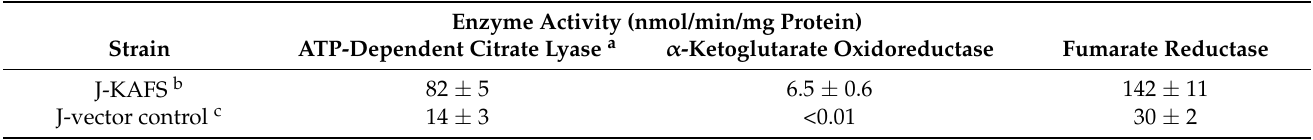
Table 1. The enzymatic activities of ATP-dependent citrate lyase, α -ketoglutarate oxidoreductase, and fumarate reductase.